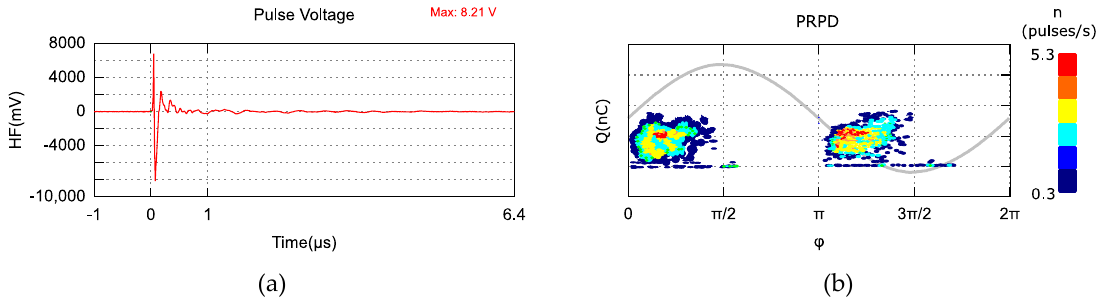
Figure 2. Partial discharge representations; ( a ) Partial Discharge (PD) waveform in time-domain. ( b ) Phase resolved Partial Discharge (PRPD) Pattern.